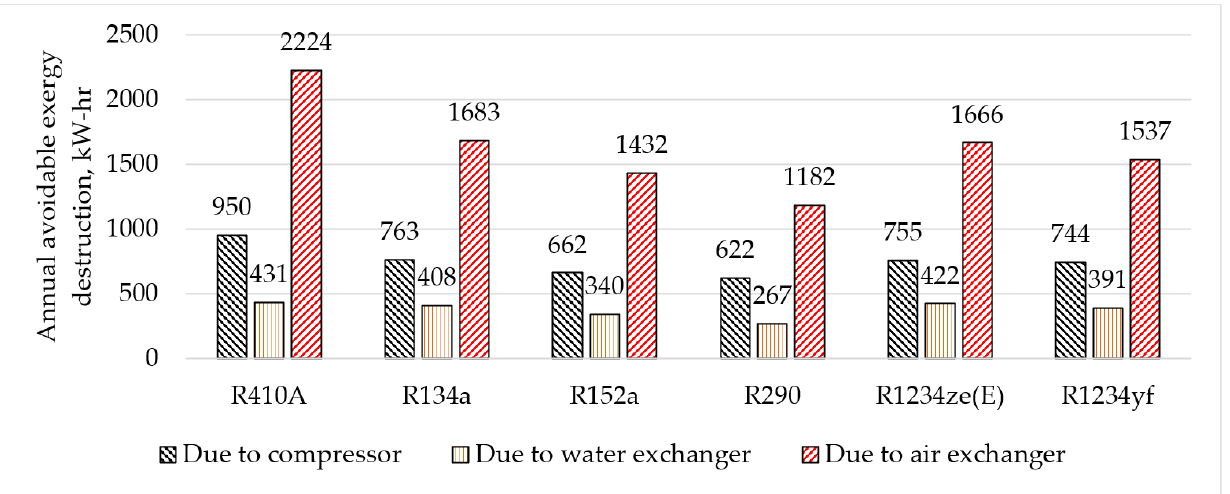
Figure 7. Annual values of the internally caused and externally caused avoidable exergy destruction AV, ,INT,EXT,yr D , k E (kWh) in the components of the investigated heat pump with different working fluids.